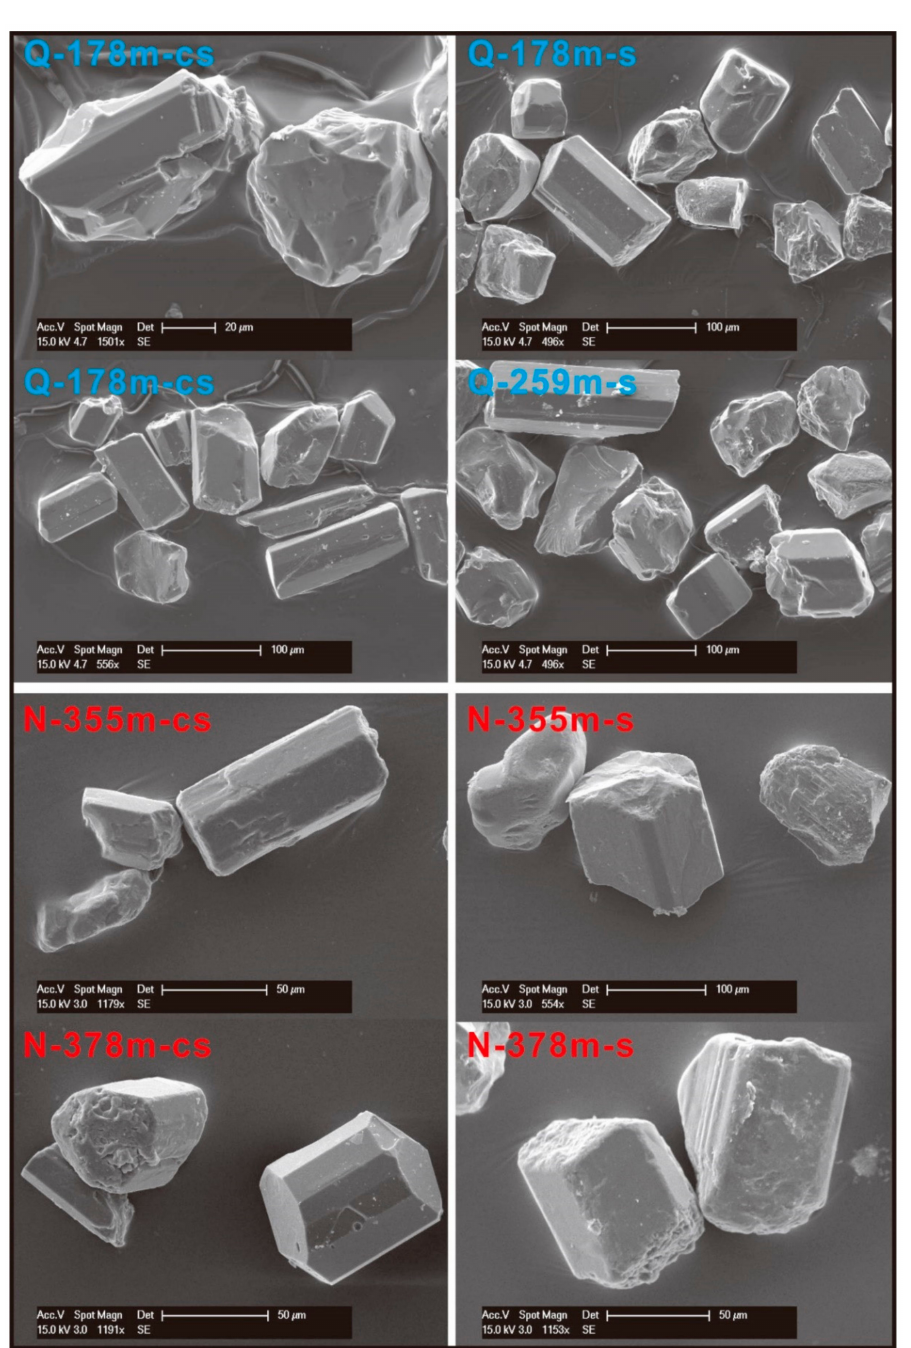
Figure 11. Surface texture of the tourmaline in the Core LQ24 of the Changjiang Delta. s = Very fine sand fraction (63–125 µ m), cs = coarse silt fraction (32–63 µ m). N = Pliocene, Q =